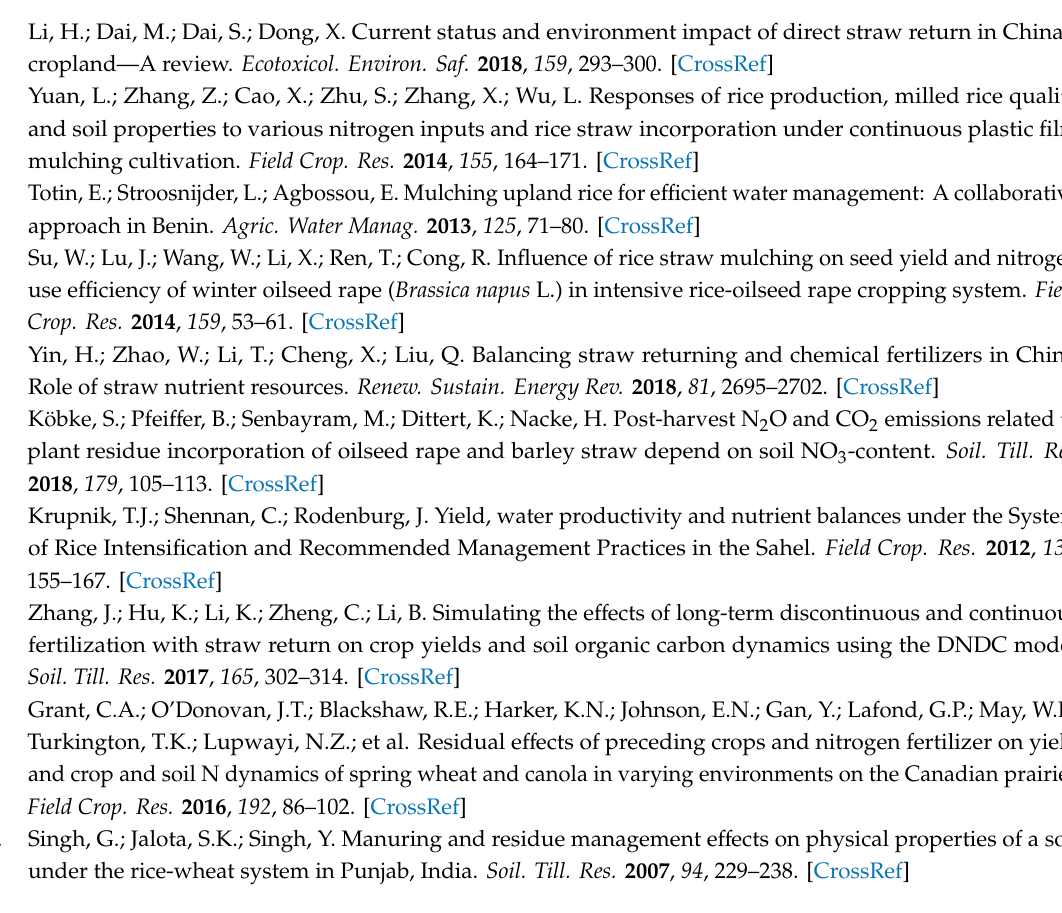
Table S9: The ANOVA analysis of the tillers and e ff ective